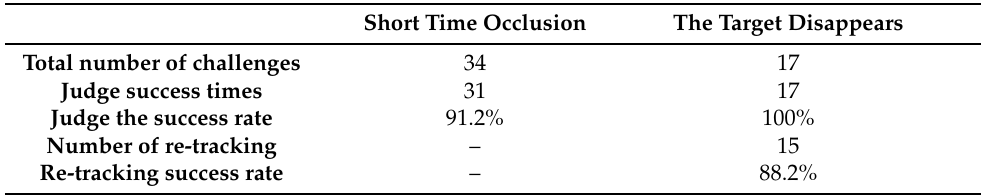
Table 2. Tracking result